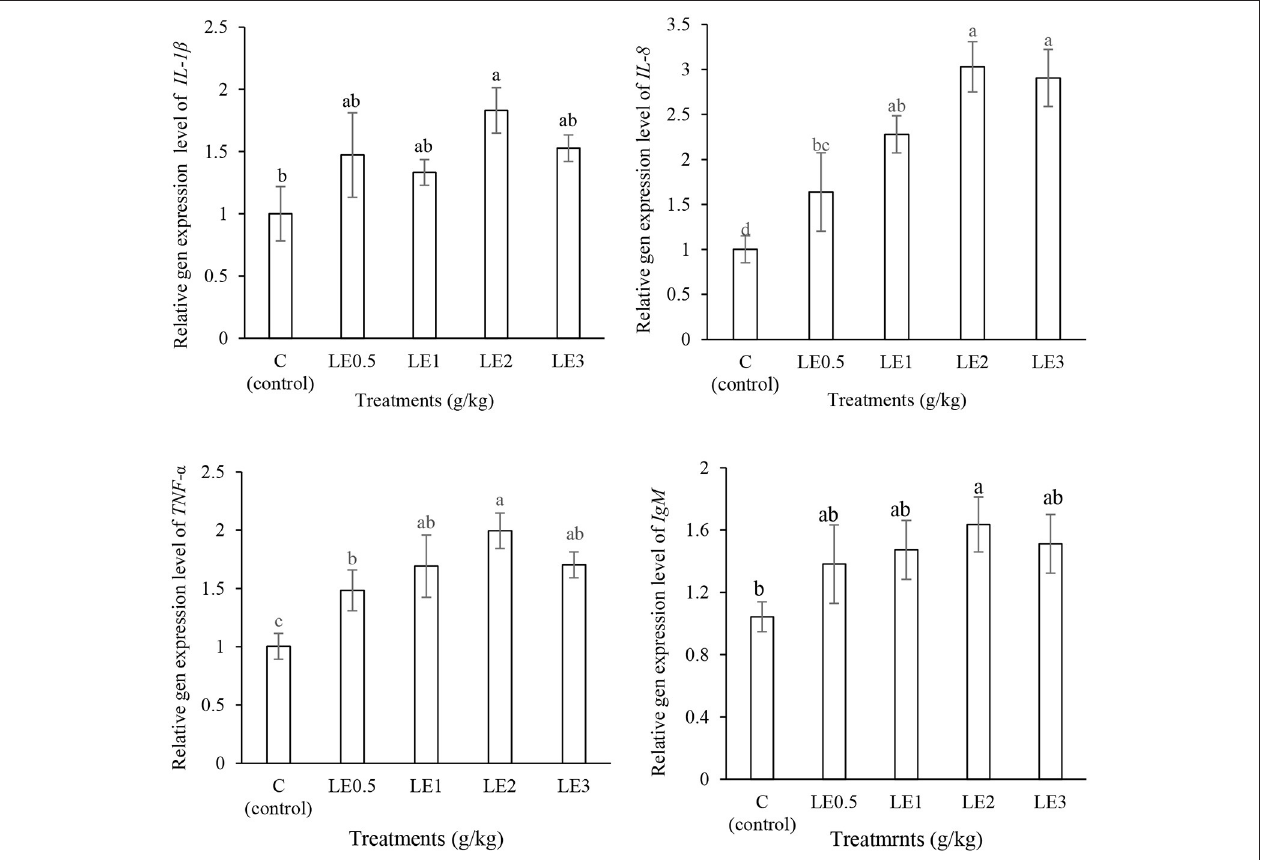
FIGURE 3 | Measurement of the levels of interleukin-1 β ( IL-1 β ), interleukin-8 ( IL-8 ), tumor necrosis factor α ( TNF- α ), and immunoglobulin M ( IgM ) gene expression in rainbow trout fed with different levels of licorice extract (LE) supplemented diets. Bars assigned with the same superscripts are not significantly different ( P > 0.05). Values are presented as the mean ± SD ( n = 3).